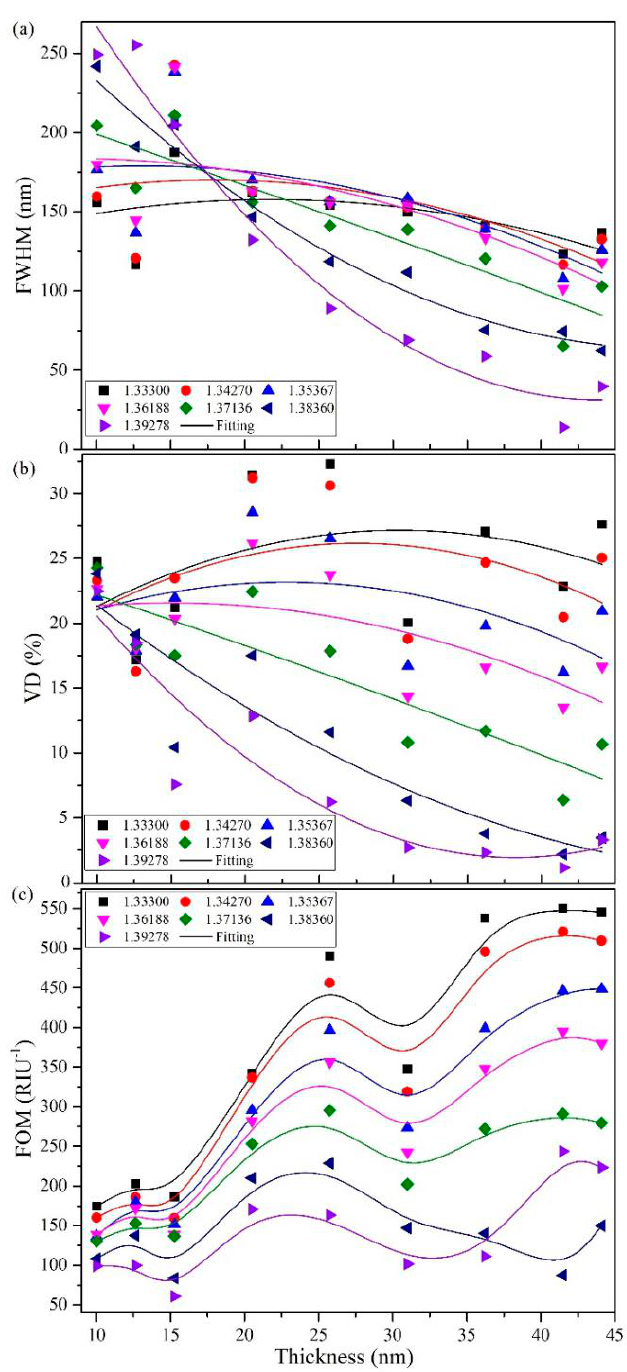
Figure 7. Gold film thickness dependence of ( a ) full width of half peak (FWHM), ( b ) valley depth (VD), and ( c ) figure of merit (FOM) during refractive index